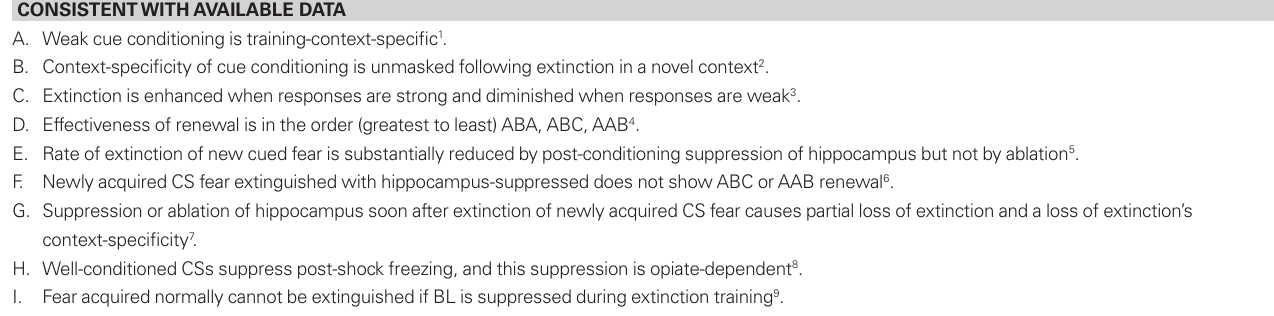
Table 4 | properties of FrAT that were not design explicit design targets. CoNsisTENT wiTH AvAilABlE